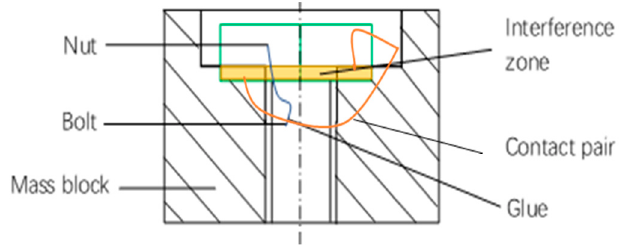
Figure 6. The schematic diagram of nut and mass block with interference. Sensors 2019 , 19 , x